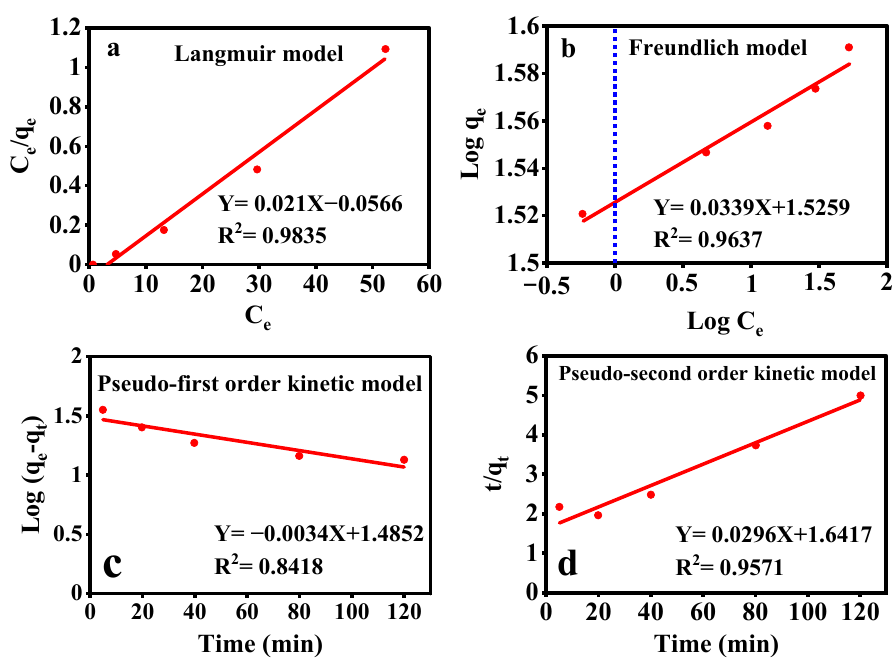
Figure 7. The equilibrium isotherms for adsorption of SMT on the γ -Fe 2 O 3 /MWCNTs/Ag NC particles: ( a ) Langmuir model, and ( b ) Freundlich model. Plots of pseudo-first ( c ) and pseudo-second order ( d ) kinetic models of the SMT adsorption on the γ -Fe 2 O 3 / MWCNTs/Ag NC particles (experimental conditions included: 0.6 g/L of the nano-adsorbent, 10 mL of the SMT solutions (5–50 mg/L), and pH = 9).